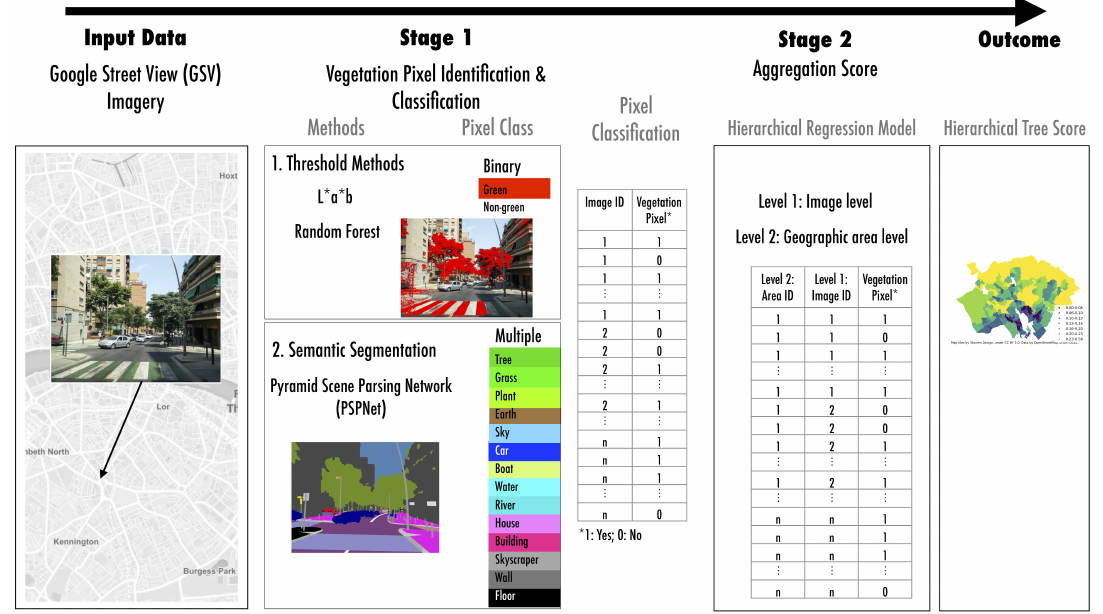
Figure 2. Methodological framework. Input data are obtained from Google Street View (GSV).